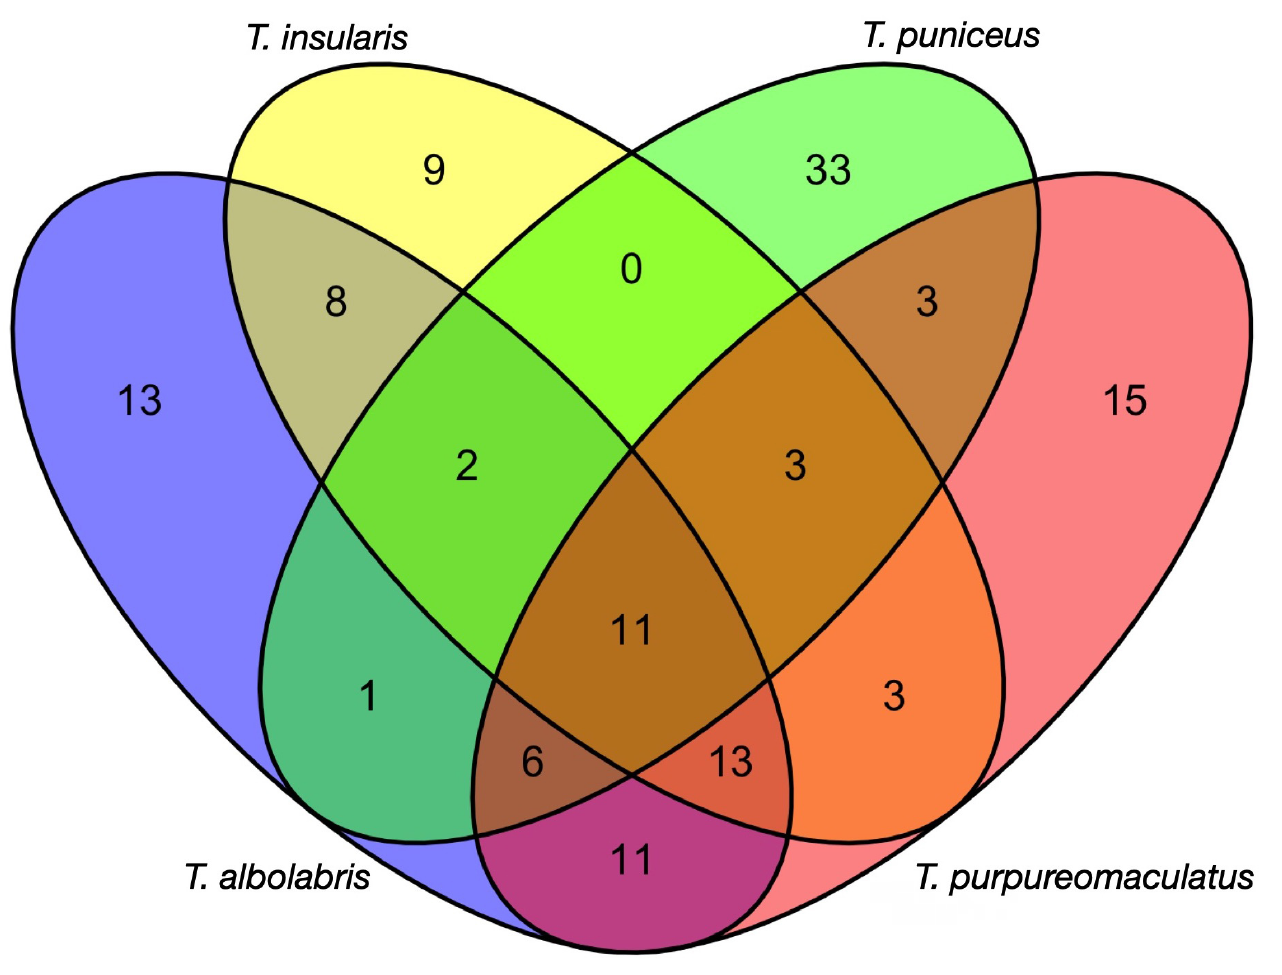
Figure 5. Venn diagram representing the number of proteins identified from four Trimeresurus venoms. Differently shaded areas indicate number of overlap proteins among the venoms.